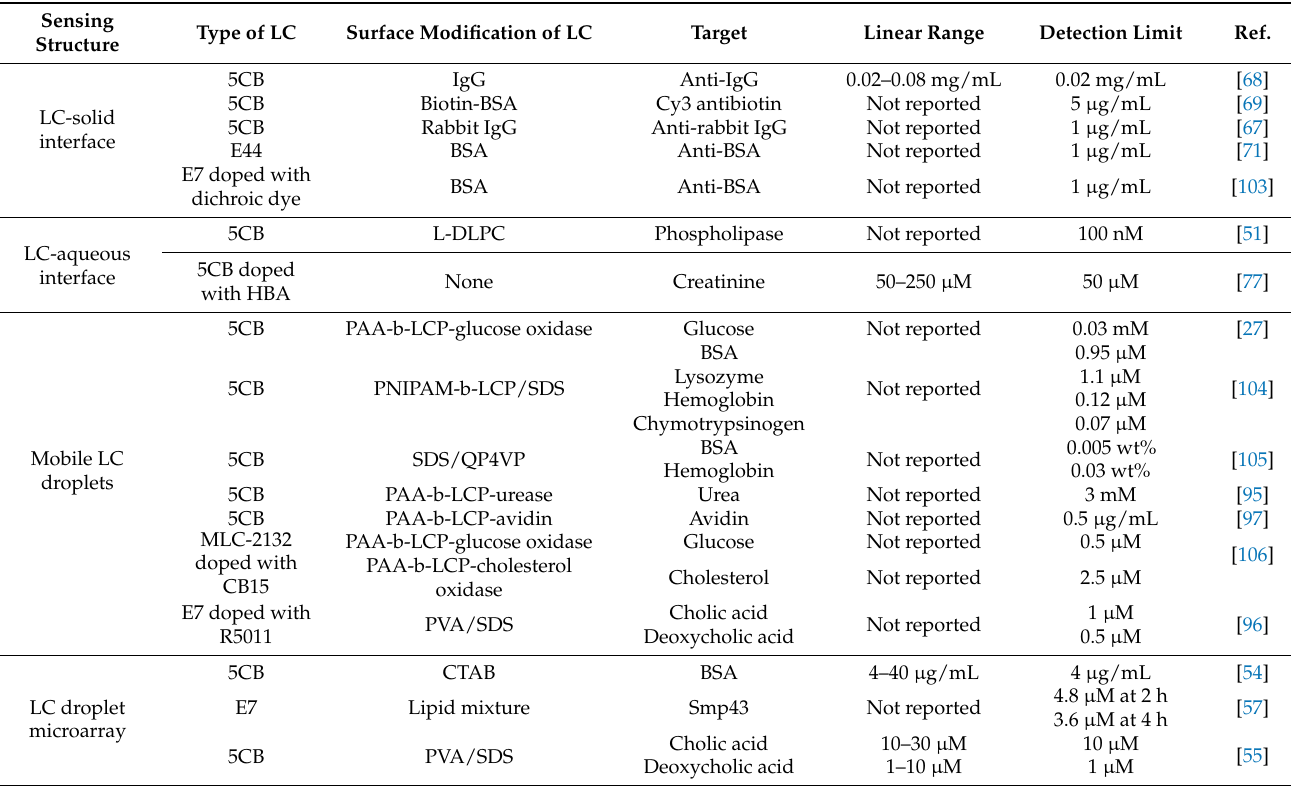
Table 1. Summary of LC-based microfluidic